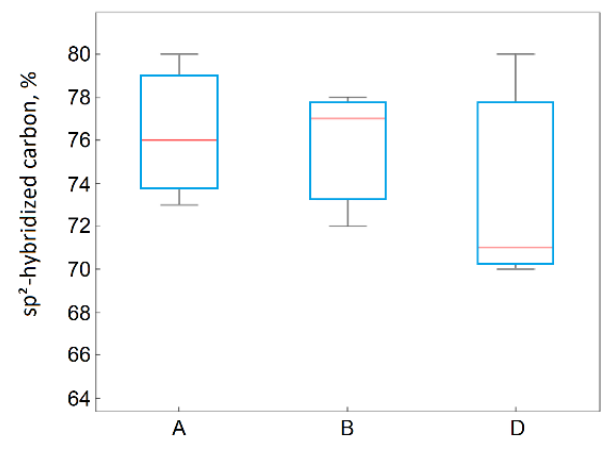
Figure 11. Box plot of C1sp 2 hybridization as a function of the applied method. On the other hand, the number of structural defects due to the elimination of oxygen groups increased. Based on the values of the I D /I G and I 2D /I D+D’ ratios determined from the Raman spectra, it was concluded that rGO obtained from the graphites oxidized using method A showed the highest amount of structural defects, while the lowest were for method B. The same observation was made for the values of interlayer distances d 00X from the XRD studies. The observed influence of the rGO method on the I D /I G ratio was statistically significant and was confirmed by the ANOVA. For the I 2D /I D+D’ ratio, this influence decreased, and due to the significant variability of the results, it became statistically insignificant (Figure 12a,b).